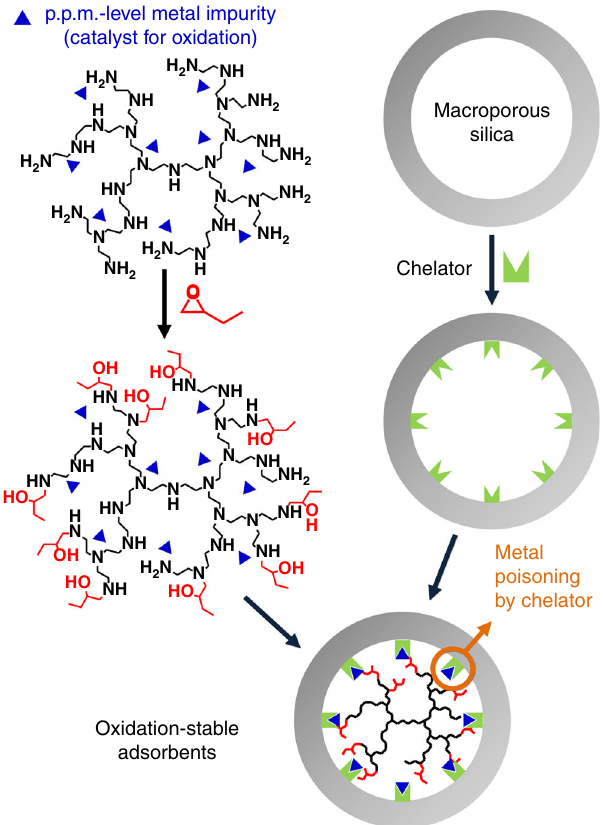
Fig. 1 Synthesis of oxidation-stable CO 2 adsorbent. PEI was functionalized with 1,2-epoxybutane (EB), which generates tethered 2-hydroxybutyl groups. Small amounts of chelators were also pre-supported into a silica support to poison p.p.m.-level metal impurities in the polymeric amines that can catalyse the oxidative degradation of